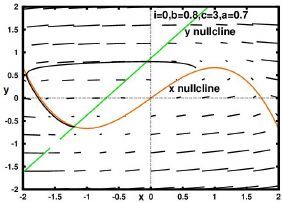
Figure 4. Phase plane, nullclines, and vec- tor field for the BVP model for I(t) = 0, a = 0.8 , b = 0.7 & c = 3